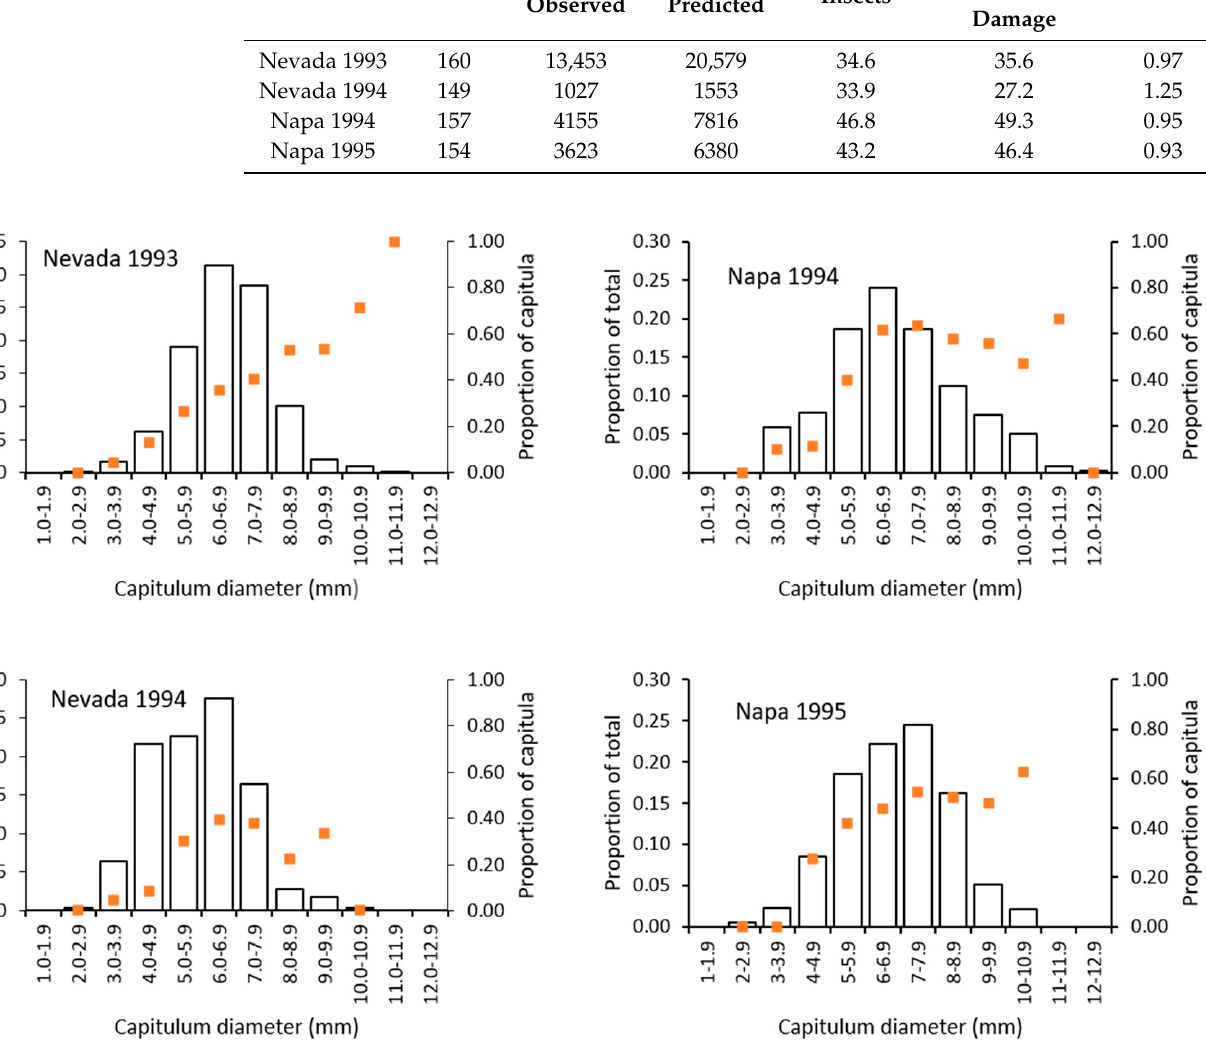
Figure 4. The relationship between capitulum size and probability of larval feeding by Eustenopus villosus for two years at two field sites. The left axis is the frequency of capitula by size (bars) and the right axis is the proportion of capitula with larval feeding damage (orange